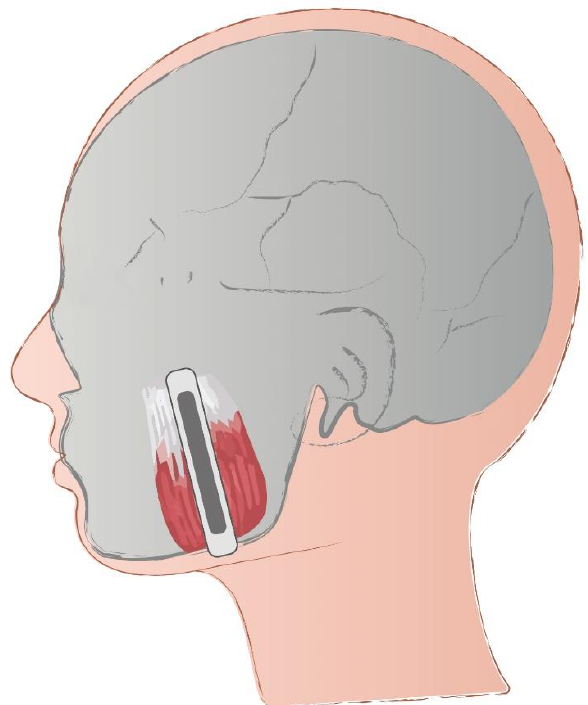
Figure 1. Placement of the probe on the masseter muscle during shear wave elastography exami- nation.